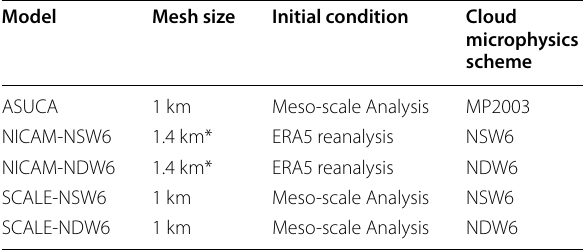
*For NICAM-NSW6 and NICAM-NDW6, the minimum mesh size of the stretched grid is provided